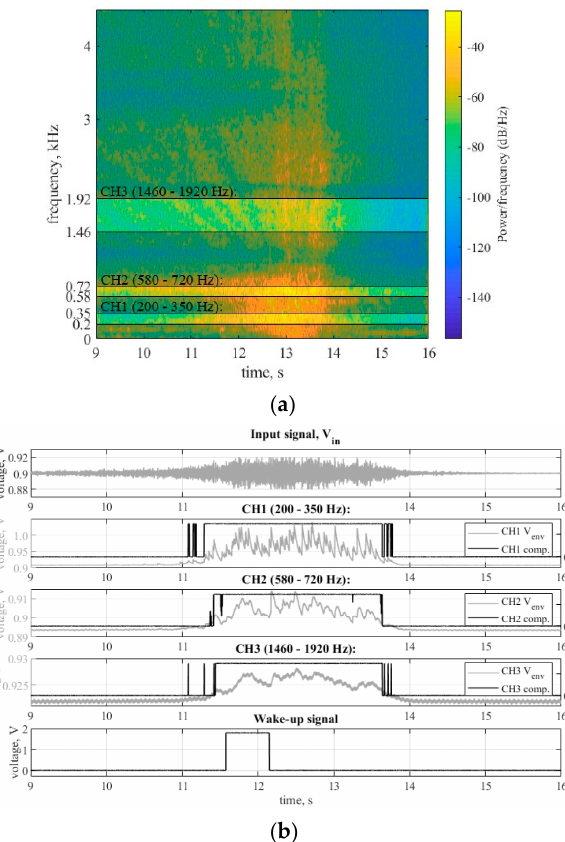
Figure 3. An acoustic event detection with the always-on wake-up circuit. ( a ) A typical